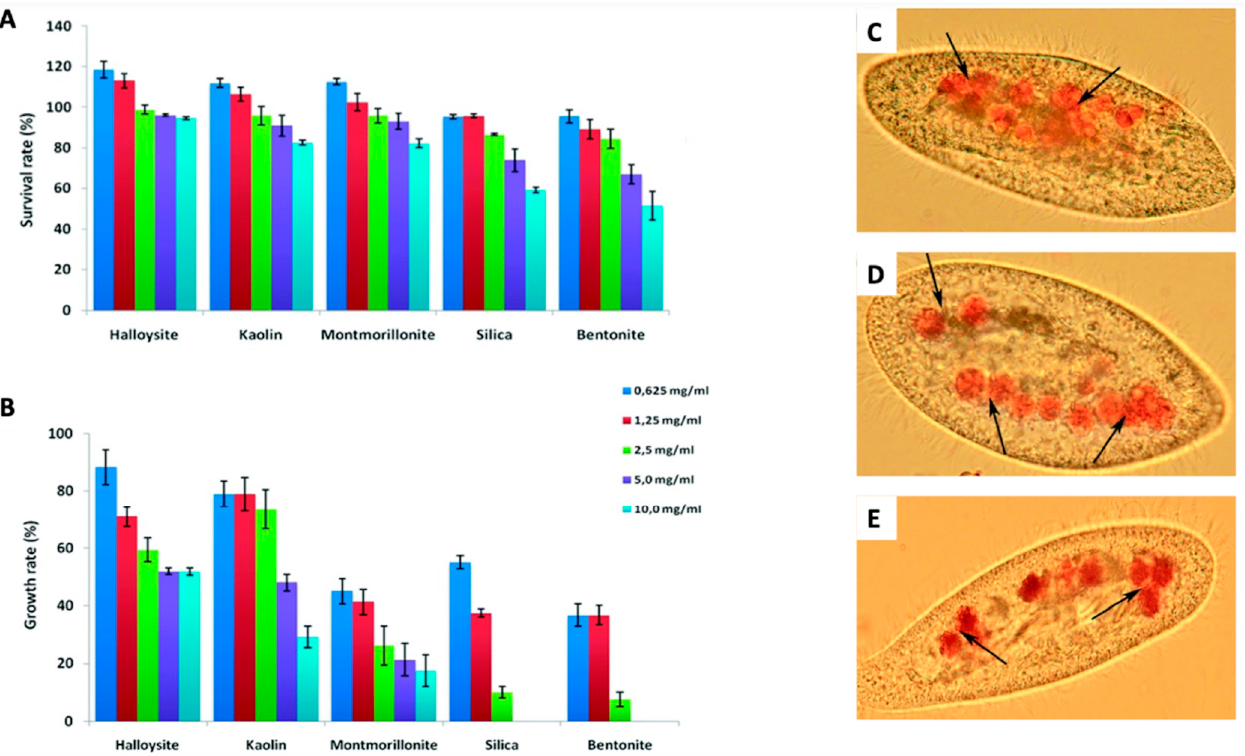
Figure 4. Acute toxicity study ( A , B ) and optical microscope images of Congo red-stained food vacuoles in P. caudatum ( C – E ). Survival rate ( A ) and growth rate ( B ) of P. caudatum cells following treatment for 24 h with increasing concentrations of NPs. Intact cell ( C ) and cells fed with HNT ( D ) and MMT ( E ). Food vacuoles are indicated by black arrows. Adapted from ref. [67].